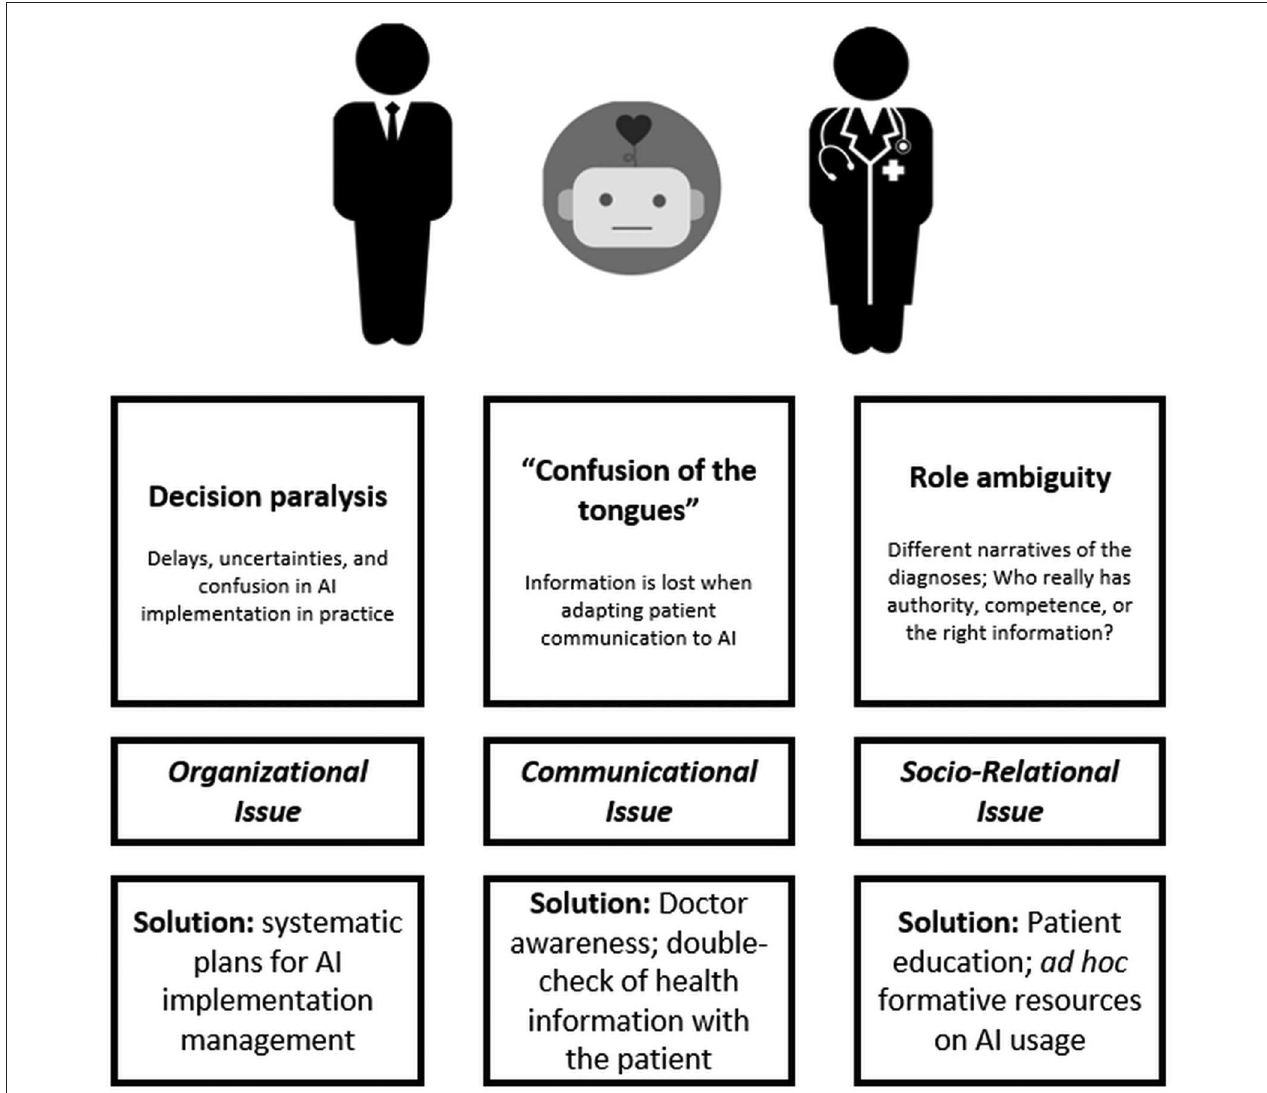
FIGURE 1 | A summary of the “third wheel” effect with possible related